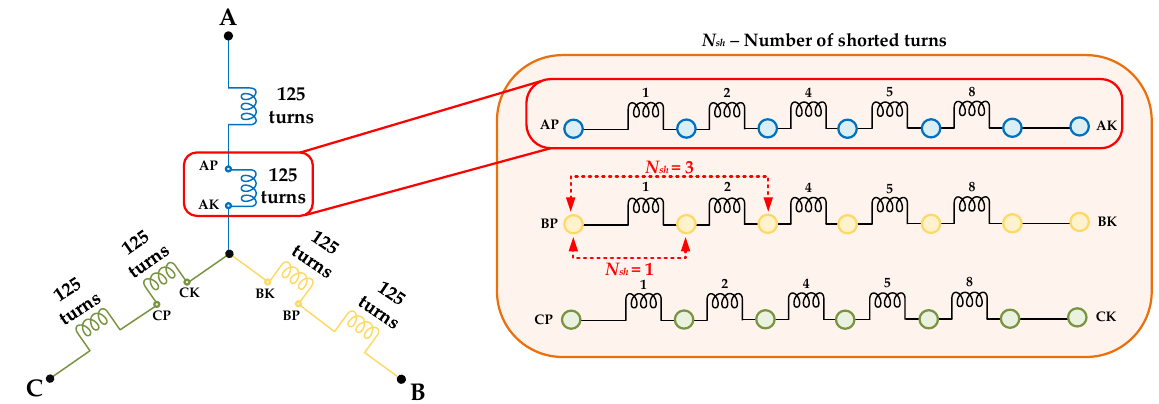
Figure 5. Illustrative diagram of the PMSM stator windings and terminal board.